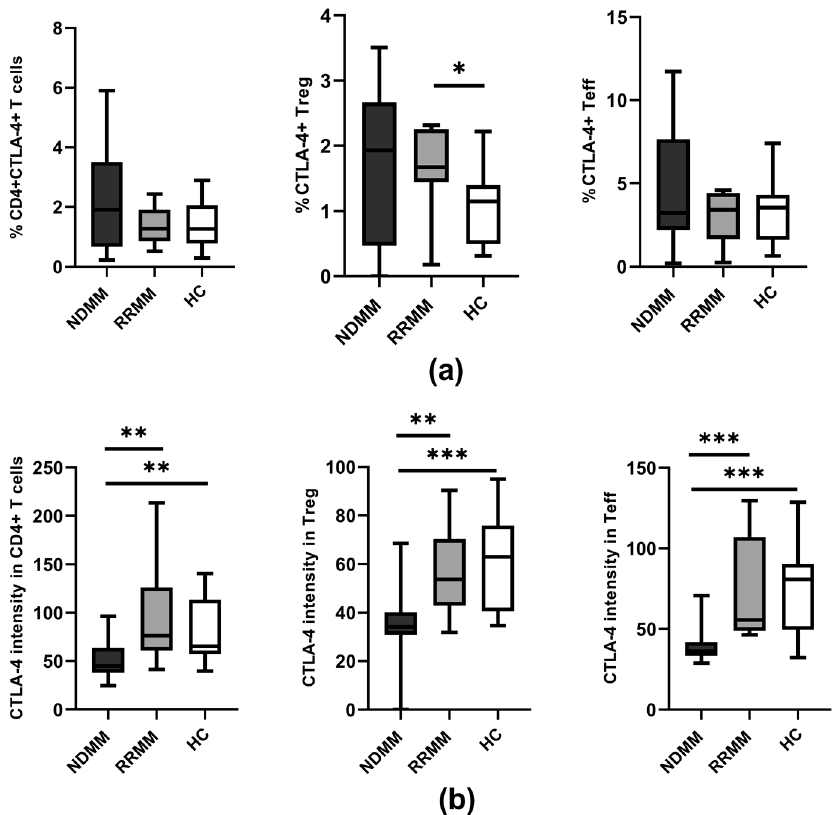
Figure 2. CTLA-4 expression on PB CD4 T cell subtypes of MM patients in the different clinical stages and healthy controls. ( a ) Frequency of CTLA-4 expressing CD4 + T cells (identified as CD3 + CD4 + ), Treg (identified as CD4 + CD127 − ), and Teff (identified as CD4 + CD127 + ) cells in healthy controls (HC) (n = 20) and patient subgroups (NDMM and RRMM) (n = 26 and n = 14, respectively). ( b ) CTLA-4 level (determined as mean fluorescence intensity) in CD4 + T cells, Treg, and Teff cells in HC (n = 20), NDMM (n = 26), and RRMM (n = 14) patients. Boxes and whiskers show 25th and 75th interquartile range and minimum–maximum, respectively; the median is the central line in each box. The differences between the studied groups were statistically evaluated using Kruskal–Wallis, ANOVA, and Mann–Whitney U tests. * p < 0.05, ** p < 0.01, *** p < 0.001.